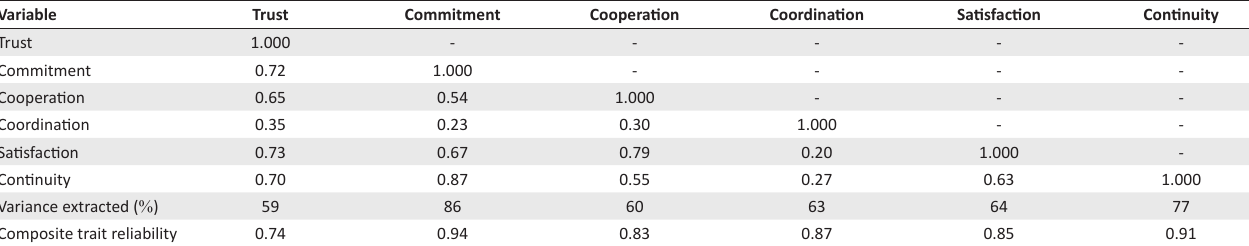
TABLE 5: Squared inter-construct correlations and summary statistics: Replication study. Variable